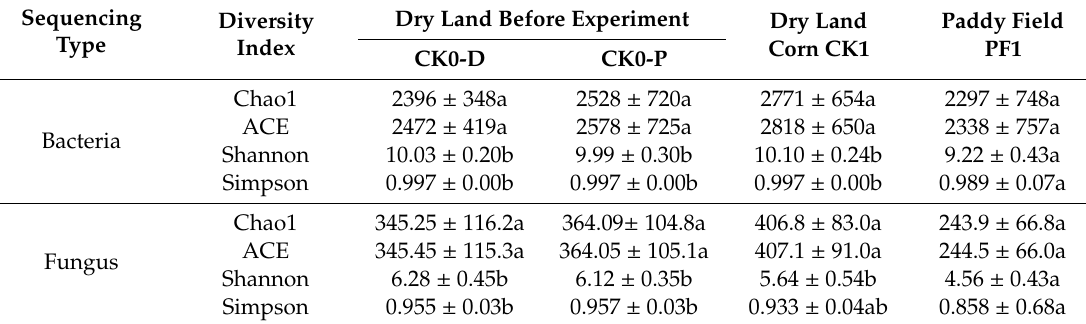
Table 2. Impacts of the dryland-to-paddy conversion on soil microbial